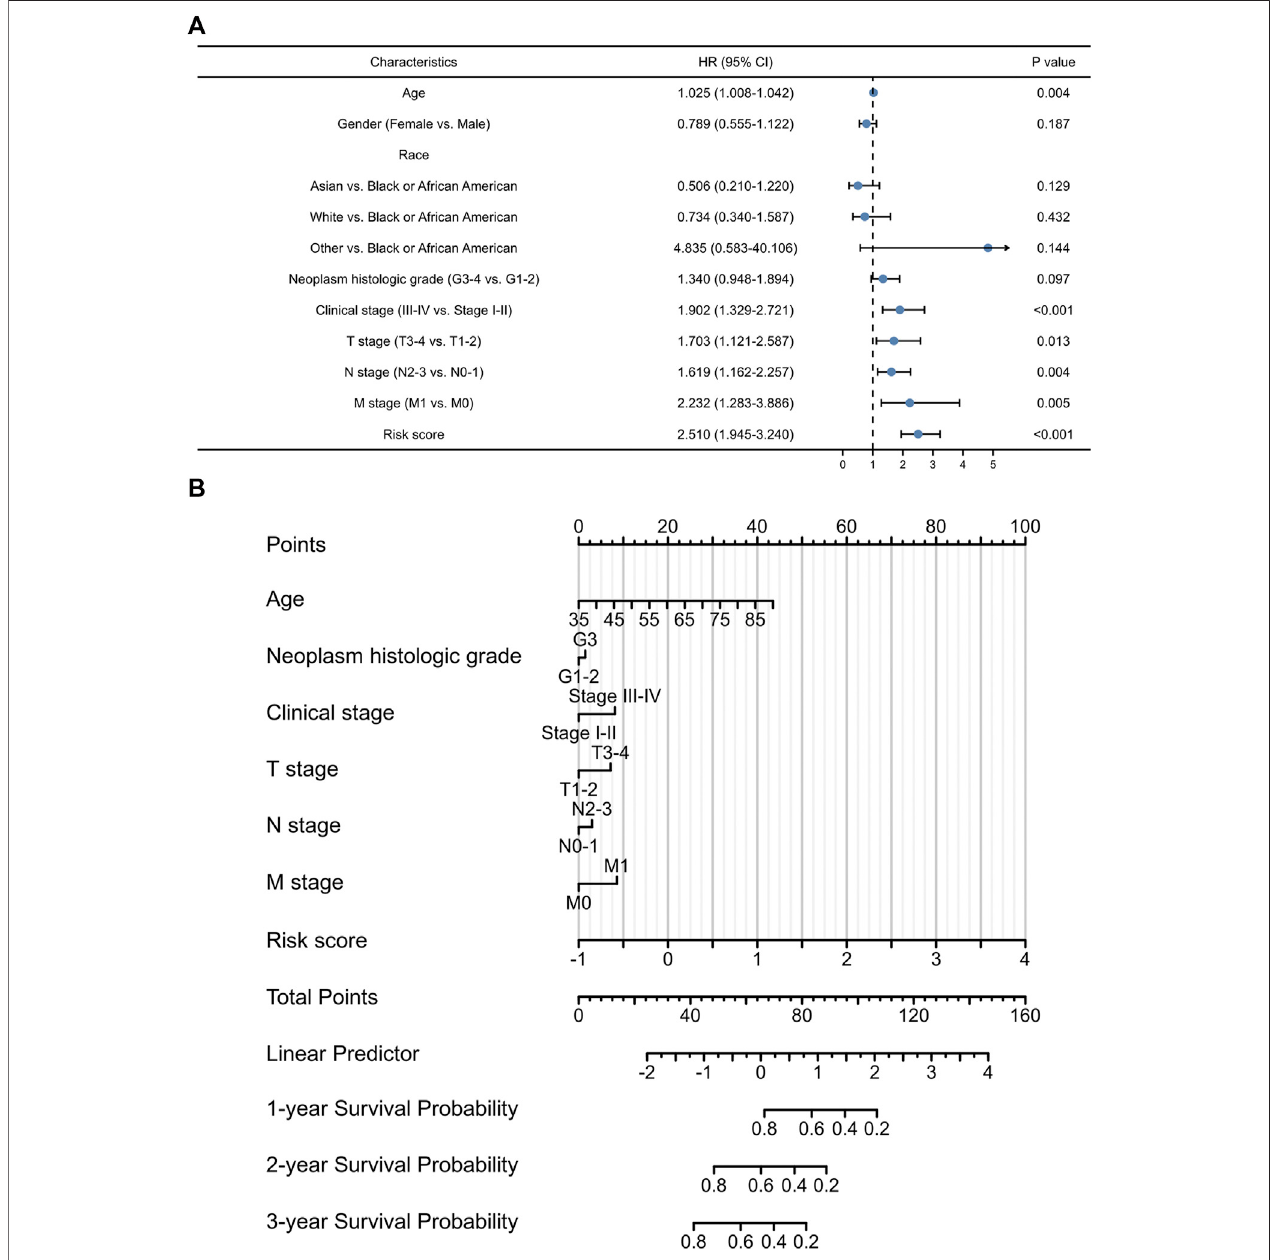
FIGURE 4 | The prognostic values of exosomes-related lncRNA signature. (A) Multivariate Cox regression of patient characters and the signature in the whole cohort. (B) The nomogram constructed using patient characters and the signature.